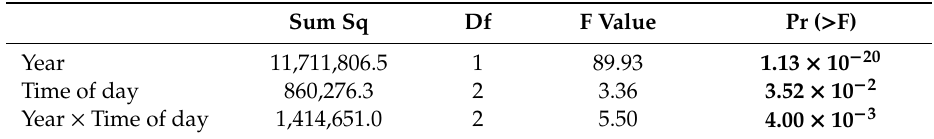
Figure 8. ( a ) Amount of nectar accumulated in individual florets in pollinator-excluded flower-heads of M. subulata over the last two years of the Chilean mega drought (Yr-1, N = 88; Yr-2, N = 77). The four asterisks (****) indicate a significant di ff erence between years ( p < 0.0001) based on the Mann–Whitney U-test. ( b ) Nectar standing crop per floret for the two years over di ff erent periods of the day (Yr-1, N = 735; Yr-2, N = 570). Outliers (values higher than 1.5 times the interquartile range above the upper quartile) are shown as dots. Four outliers were excluded from ( b ) to facilitate visual presentation. Note that these outliers were not excluded from the statistical analysis. Lower case letters indicate significant differences ( p < 0.05) according to Dunn’s test. Table 3. Results of nonparametric factorial analysis (aligned ranks transforms) for nectar standing crop in M. subulata over the last two years of the Chilean mega drought. Significant e ff ects are shown in bold. Sum Sq Df F Value Pr ( >